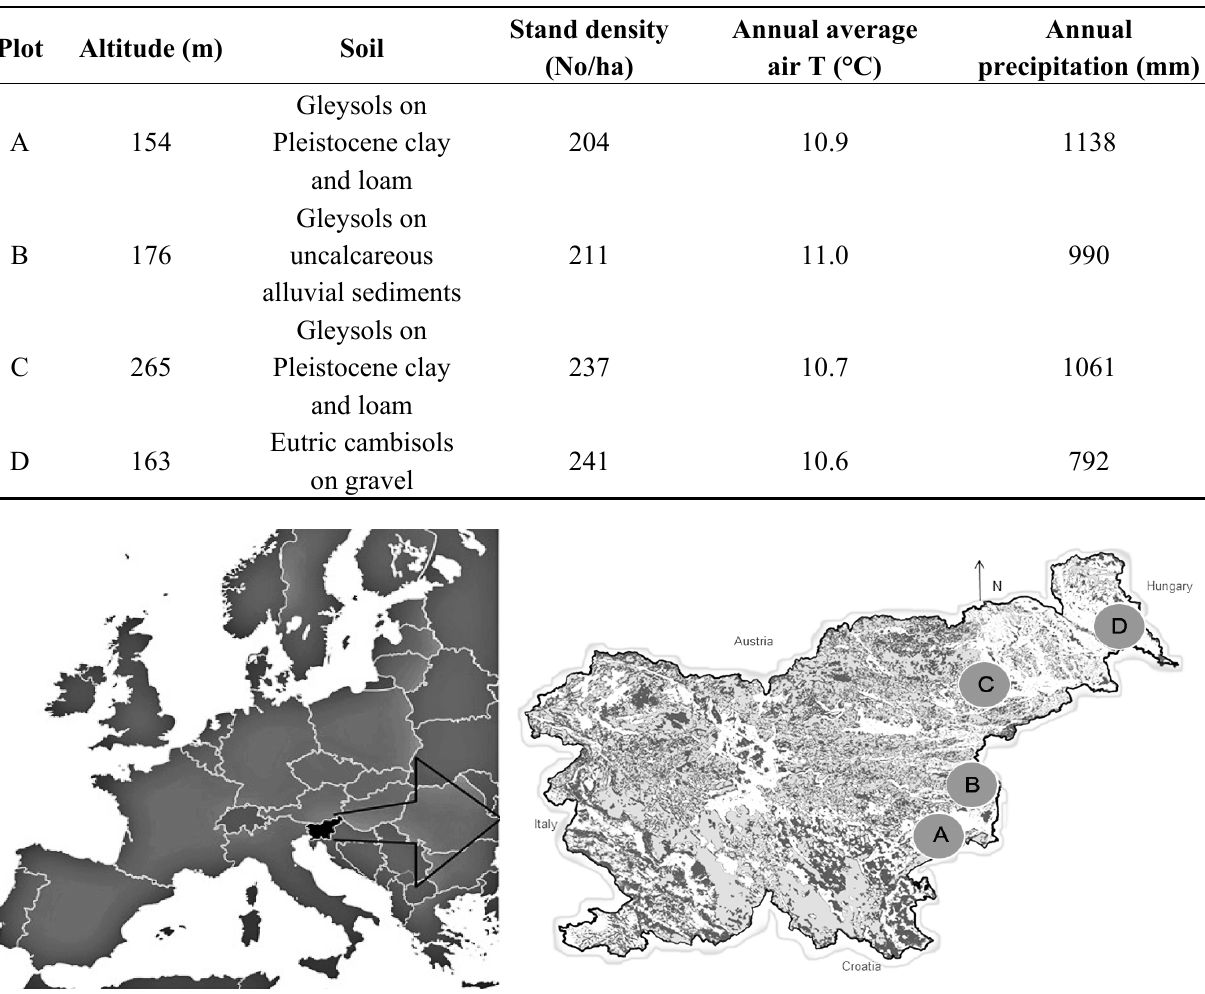
Table 1. Characteristics of the research plots.